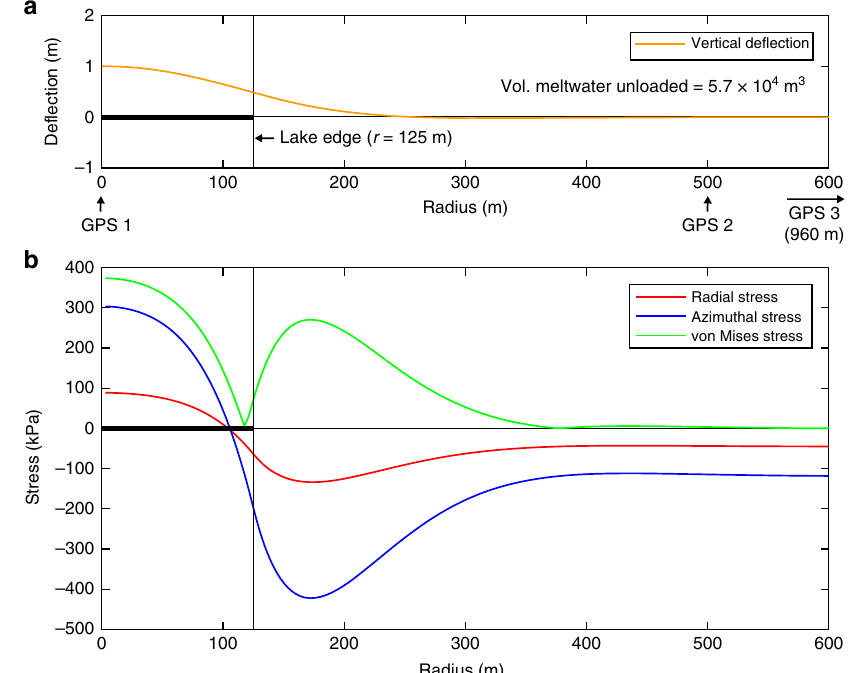
Fig. 5 Vertical ice shelf de fl ection and stresses associated with the drainage of Ring Lake. a Vertical ice-shelf de fl ection (orange line), as a function of distance from lake centre, is computed by an exact analytic solution for thin elastic plate fl exure above seawater, in response to the drainage of Ring lake (of volume 5.7 × 10 4 m 3 , equal to the calculated seasonal net meltwater budget within a 250 m radius of Ring lake GPS 1, Fig. 3a). This result shows the best match between the analytic solution and the measured de fl ection at Ring lake ’ s centre (i.e. GPS 1) and uses the following parameter values: R = 125 m, H = 10 m, and E = 1 GPa. The locations of GPSs 1, 2, and 3 (960 m from the lake centre) are indicated. The associated stresses (radial (red line), azimuthal (blue line), and von-Mises (green line) as a function of distance from lake centre), shown in b , are all evaluated at the upper ice-shelf